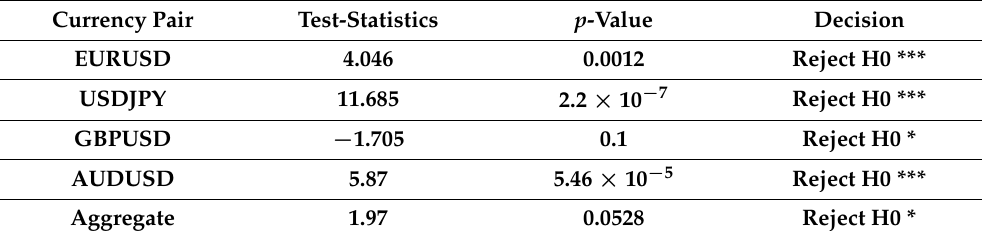
Table 5. The t -test results which corresponds to the F1-score performance distribution in Figure 2b. A total of 20 models were trained on each dataset (currency pair) where a set of 10 models was trained with the SR levels identified and a set of 10 models was not. t -Test is used to measure the statistical significance of the performance distribution differences between the 2 sets. *** and * refer to the 99% and 90% confidence coefficient, respectively. Results show that the performance distribution differences are significant for all datasets.